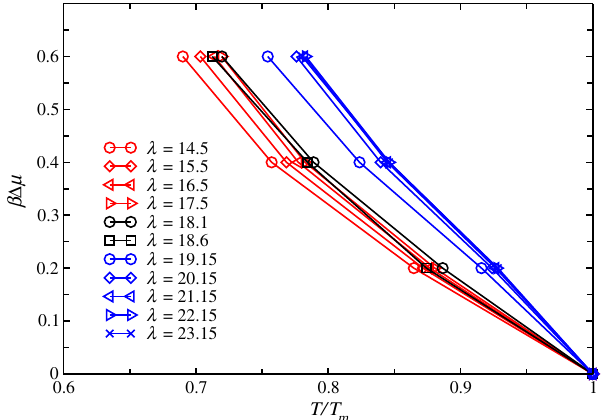
FIG. 7. (a) Thermodynamic driving force ( β Δ μ ) along 0 . 8 . (b) Thermodynamic interface penalty ( βγ ) for the T=T for m ¼ m same points as in (a).